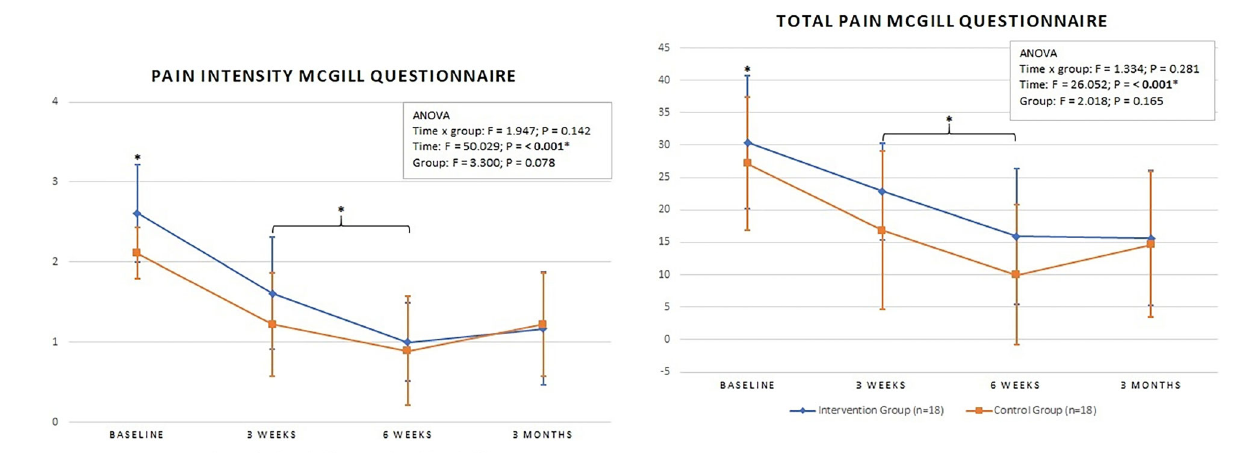
Figure 3. Mean total pain values at baseline, 3 weeks, 6 weeks, and 3 months. Intervention Group: completed cases in intention- to-treat analysis. Data are reported as means ± SD. *P o 0.05 for time (total pain: sensory, affective, evaluative, and mixed pain aspects);